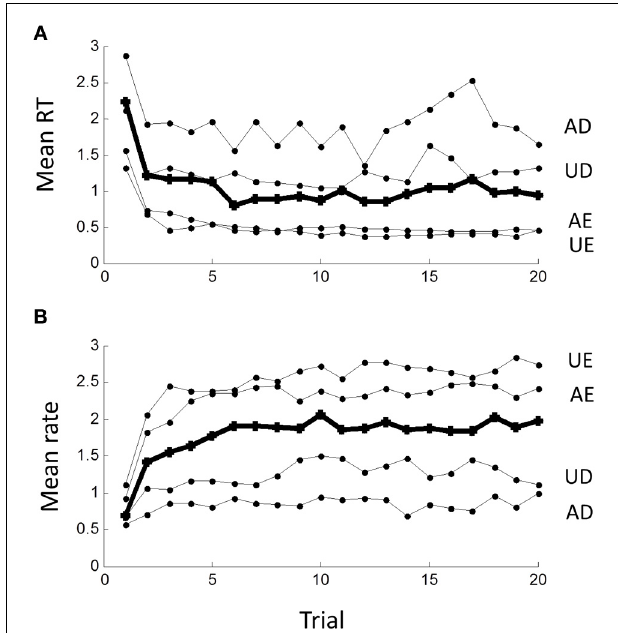
FIGURE 7 | Non-stationarity of responses in (A) the time-domain and (B) the rate-domain. Means are computed across all subjects for the first 20 responses in each block; grand mean across conditions shown by thick line. Note initial transient lasting less than 10 trials, which is more pronounced for the AE and UE blocks.